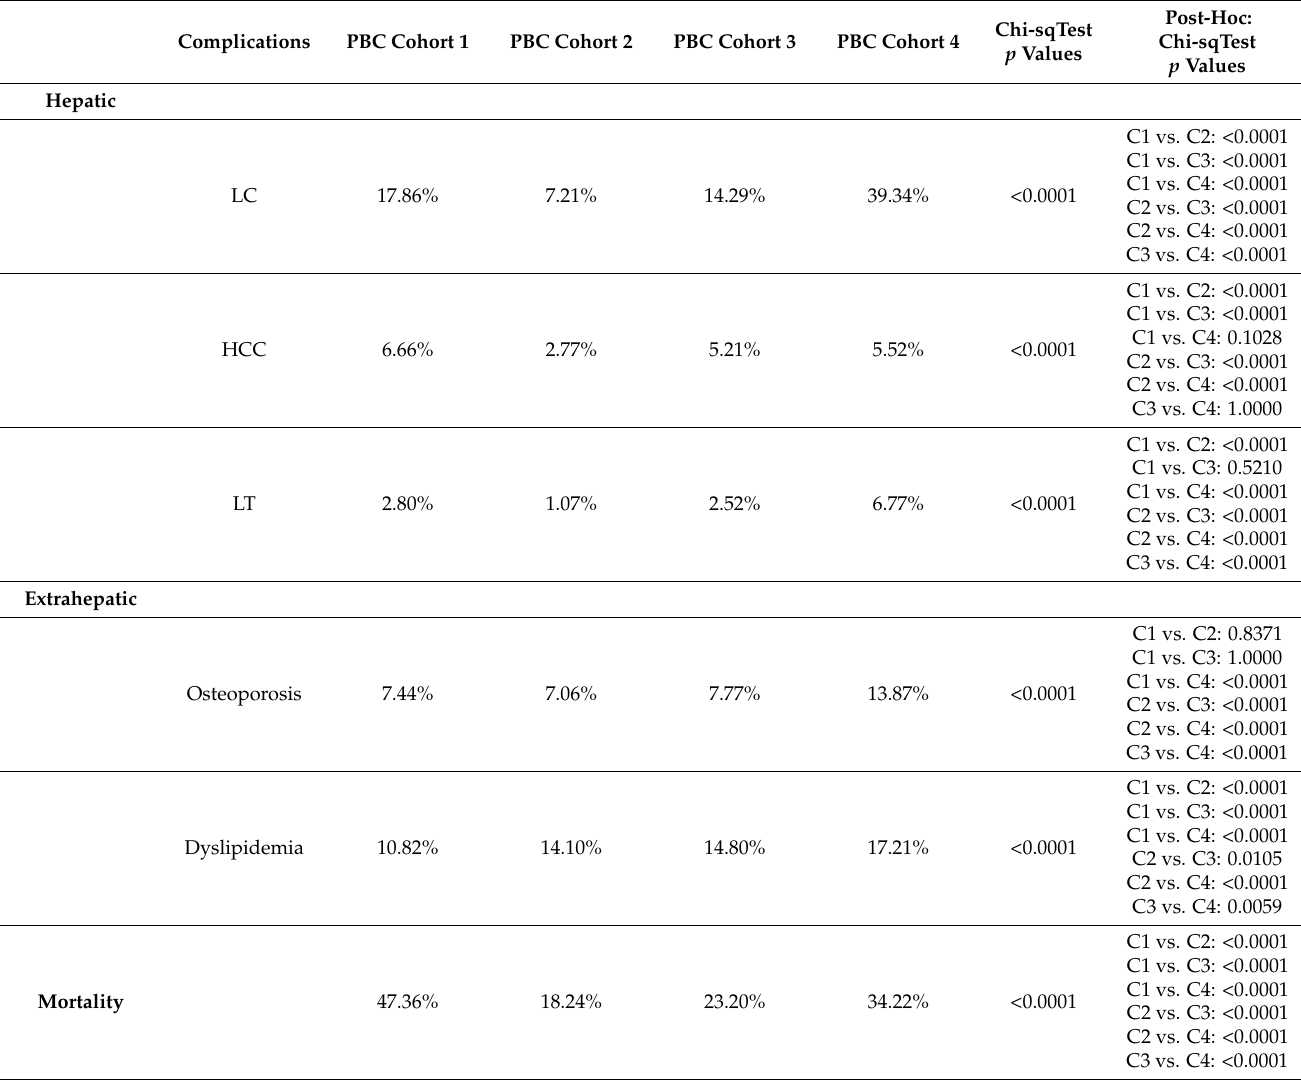
Table 4. Prevalence rates of various complications of 4 PBC